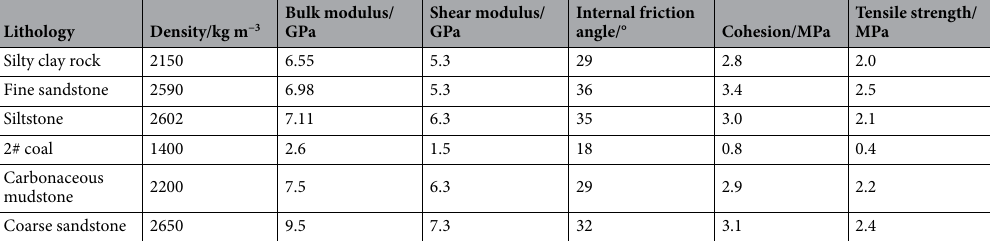
Table 2. Actual physical and mechanical properties of each stratum.